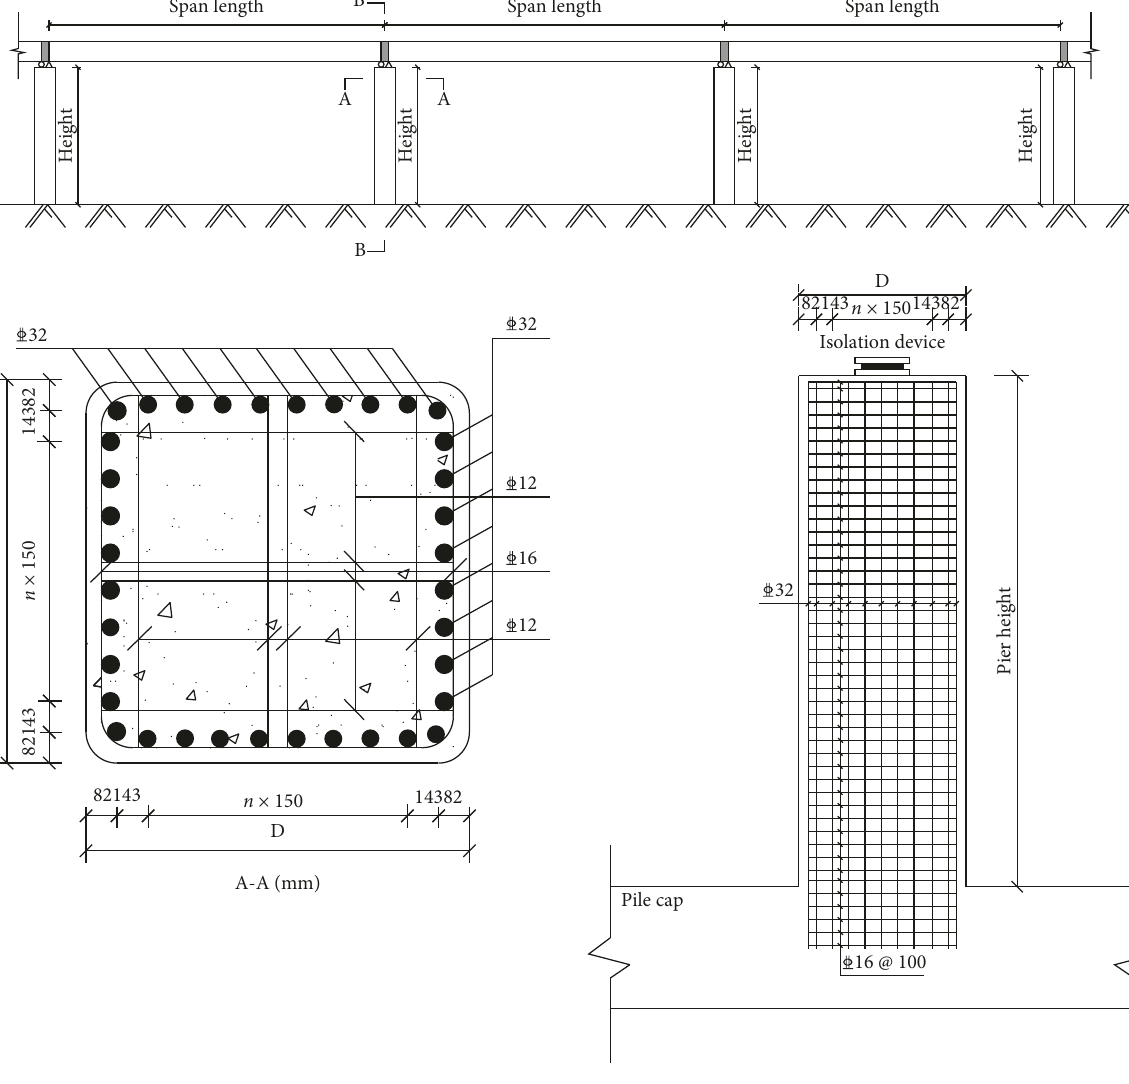
Figure 2: Elevation and pier section properties of simply supported girder